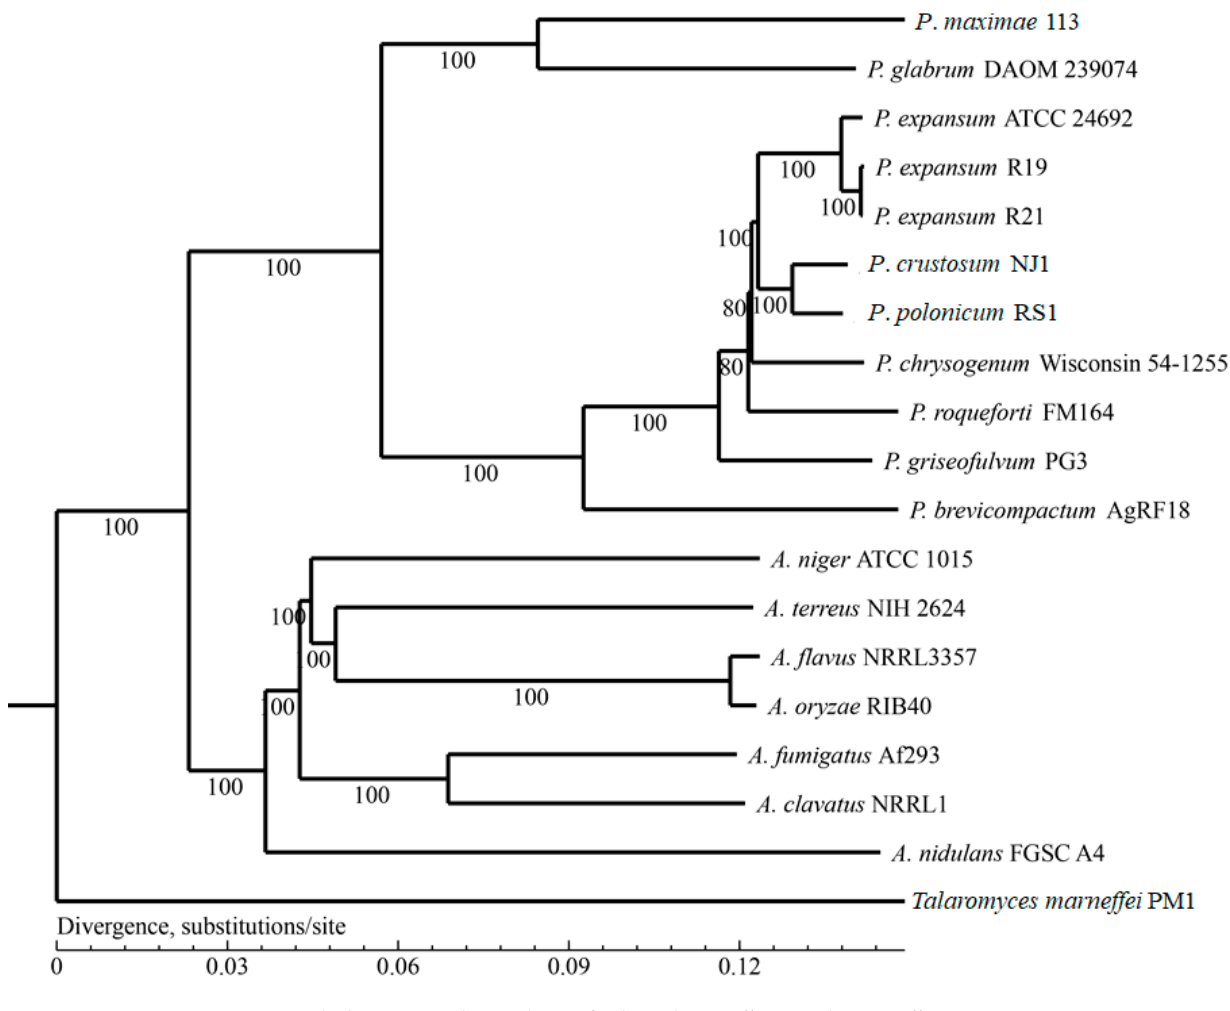
Figure 3. Phylogenetic relationships of selected Penicillium and Aspergillus species.